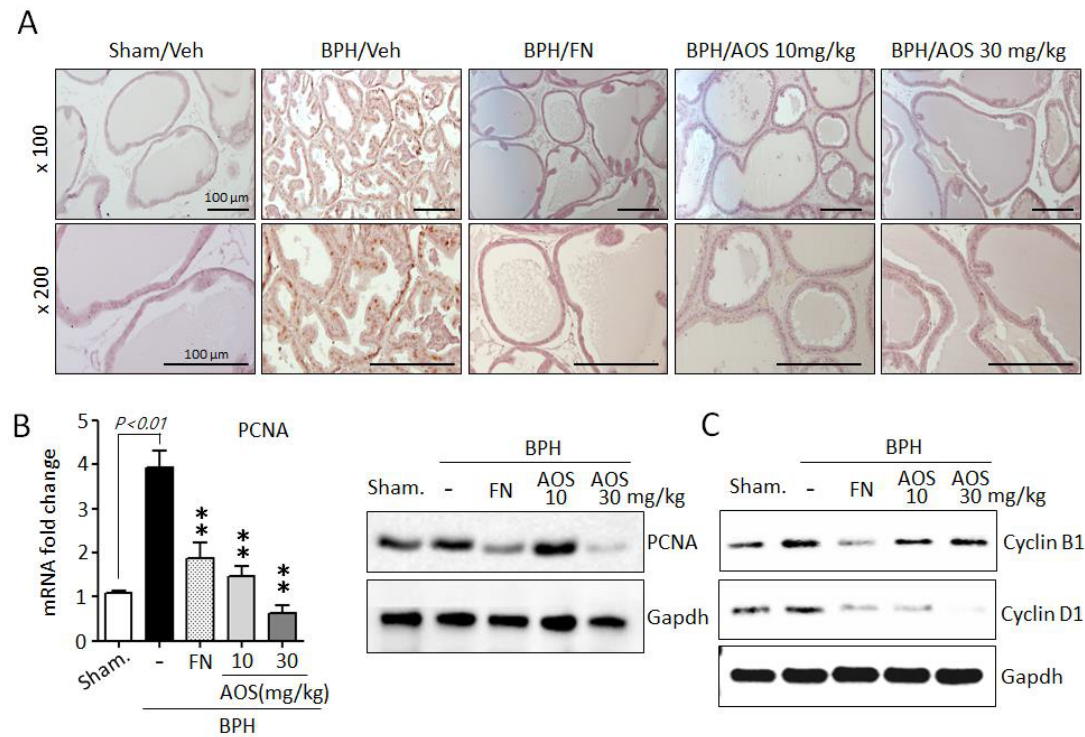
Figure 5. Effect of AOS on cell proliferation in the prostatic tissues of rats with testosterone propionate (TP)-induced benign prostate hyperplasia (BPH). ( A ) Representative photographs of IHC-stained prostatic tissues with anti-PCNA antibodies (magnification, × 100, and × 200). Scale bar, 100 µ m. ( B ) Levels of mRNA and protein expression of PCNA in prostatic tissues were analyzed using real-time quantitative PCR and Western blot analysis. The data are presented as mean ± standard deviation ( n = 5 per group); ** p < 0.01 compared with the BPH/Veh group. ( C ) Western blot analysis for assessing the protein levels of cyclin B1 and cyclin D1 in rat prostatic tissues. Glyceralde-hyde-3-phosphate dehydrogenase (Gapdh) was used as an internal control. Data are representative of three independent experiments. Legend: Sham/Veh, the sham-operated group used as a negative control; BPH/Veh, castrated rats receiving TP + vehicle; BPH/FN, castrated rats receiving TP + finasteride; BPH/AOS, castrated rats receiving TP + different concentrations of AOS.